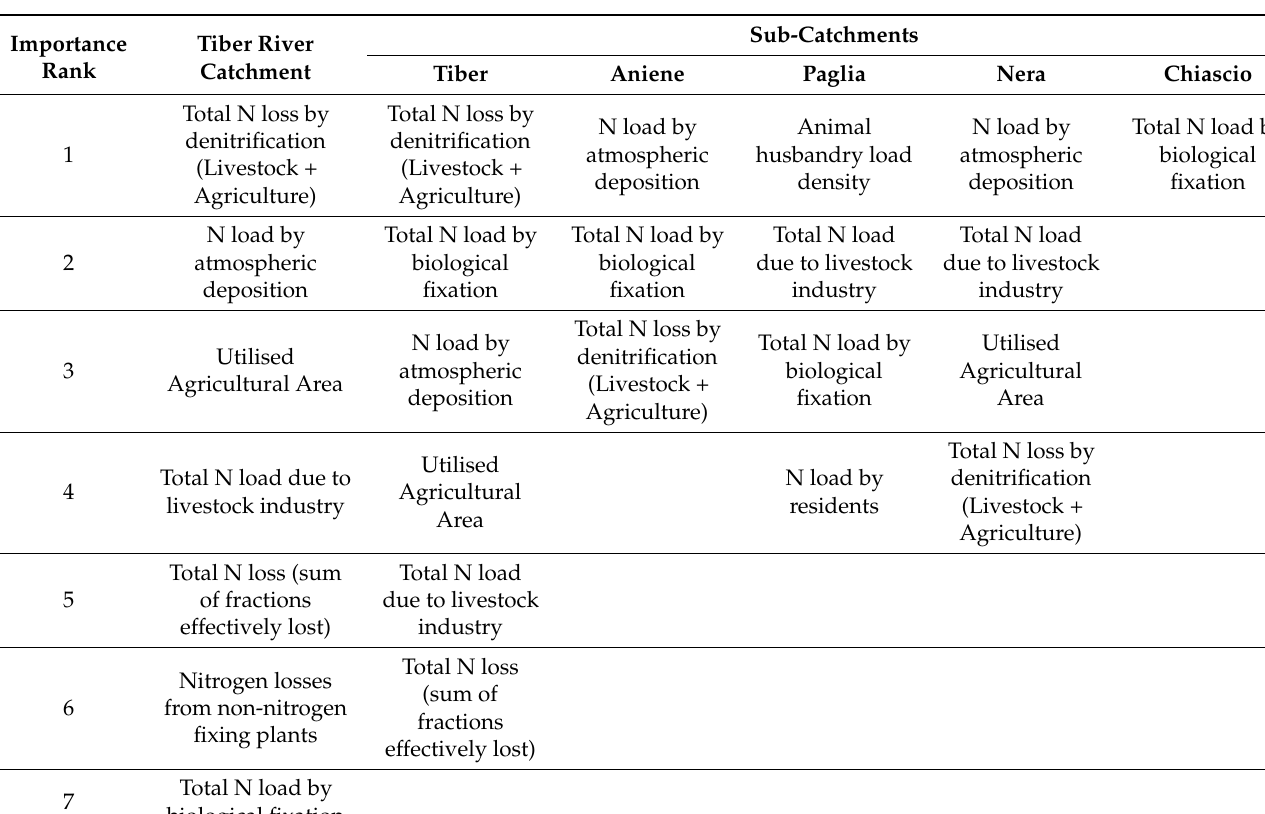
Table 3. The most important variables affecting the N retention are sorted by their importance in the Tiber catchment and its sub-catchments. The Random Forest analysis was not able to fulfil the minimal threshold of the monitoring sites (equal to or above 20 sites) for the sub-catchments Nestore, Cerfone, Farfa, and Treja; therefore, these were not reported in this